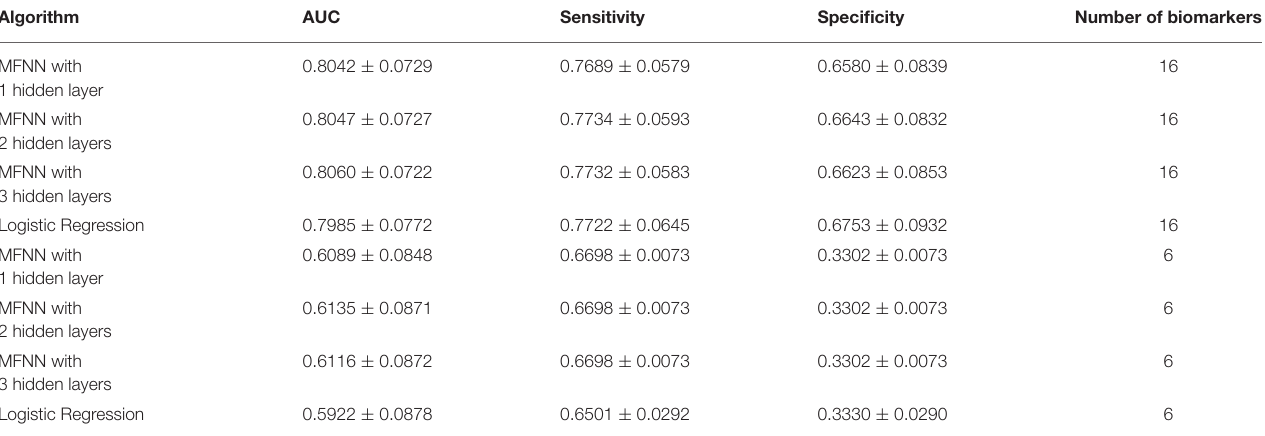
TABLE 5 | The results of repeated 10-fold cross-validation experiments for predicting remission using multilayer feedforward neural networks (MFNNs) and logistic regression with 16 biomarkers and 6 clinical biomarkers only.